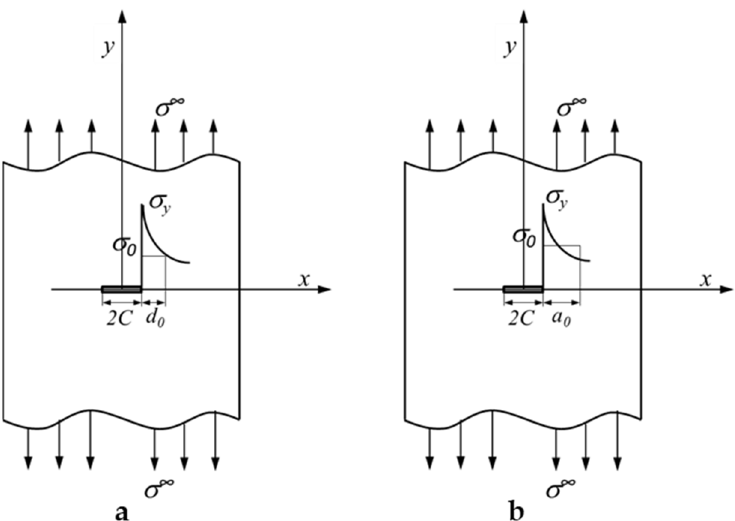
Figure 2. Stress relationship of an infinite-width plate with a straight slot under tensile load under the Whitney and Nuismer criteria. ( a ) Point stress criterion (PSC) failure occurred when stress in the notched plate at distance d 0 away from a hole or crack is equal to the strength of a corresponding non-notched plate. ( b ) Average stress criterion (ASC) failure is assumed to occur when the average stress over distance a 0 is equal to the strength of a non-notched plate.